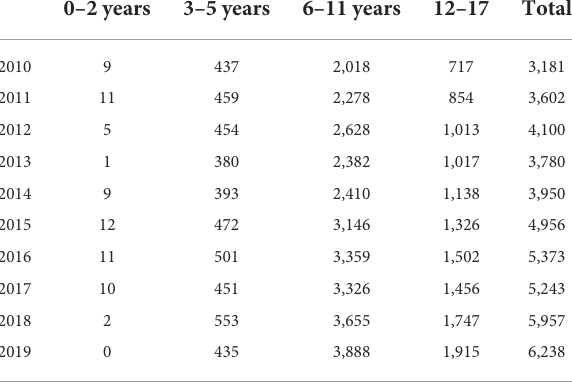
TABLE 2 The ratio of children treated with MPH among children with ADHD hospitalized in France between 2011 and 2019. ADHD ADHD without